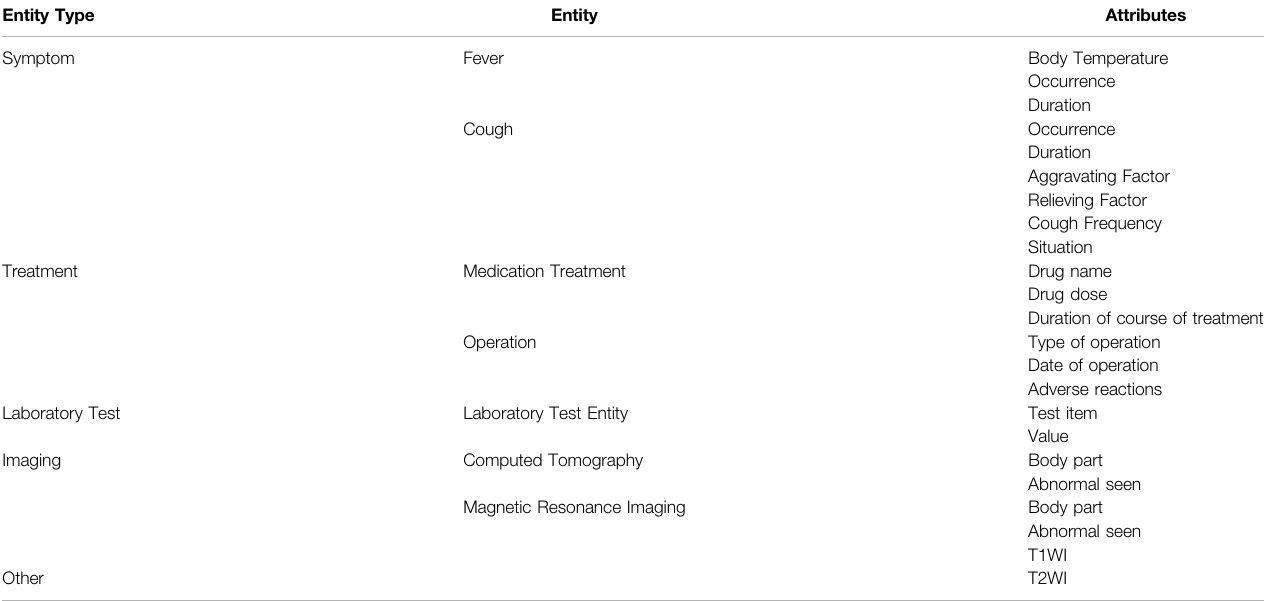
TABLE 1 | Medical knowledge graph schema label for information extraction.